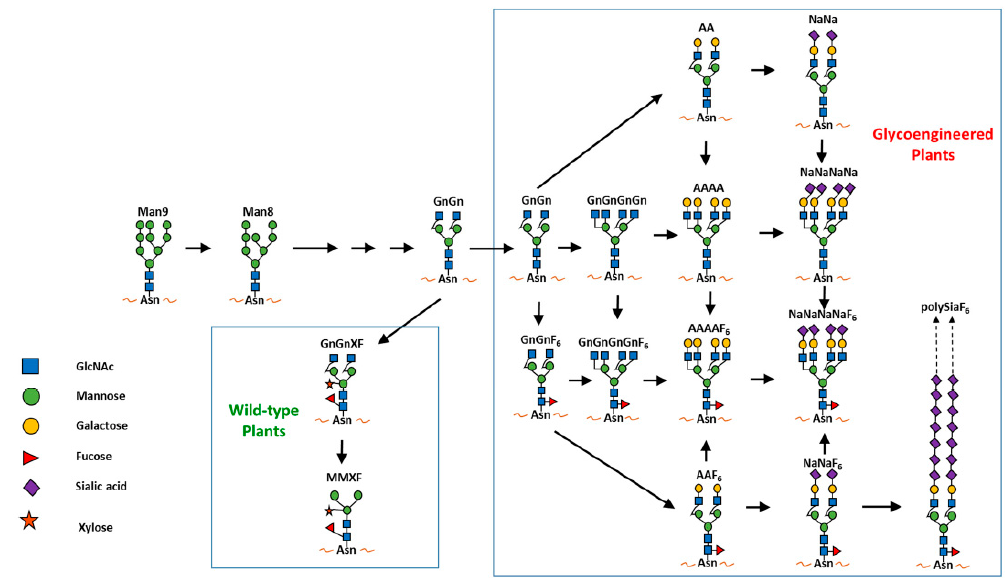
Figure 3. Major N -glycan structures produced in wild-type and glycoengineered plants [145].